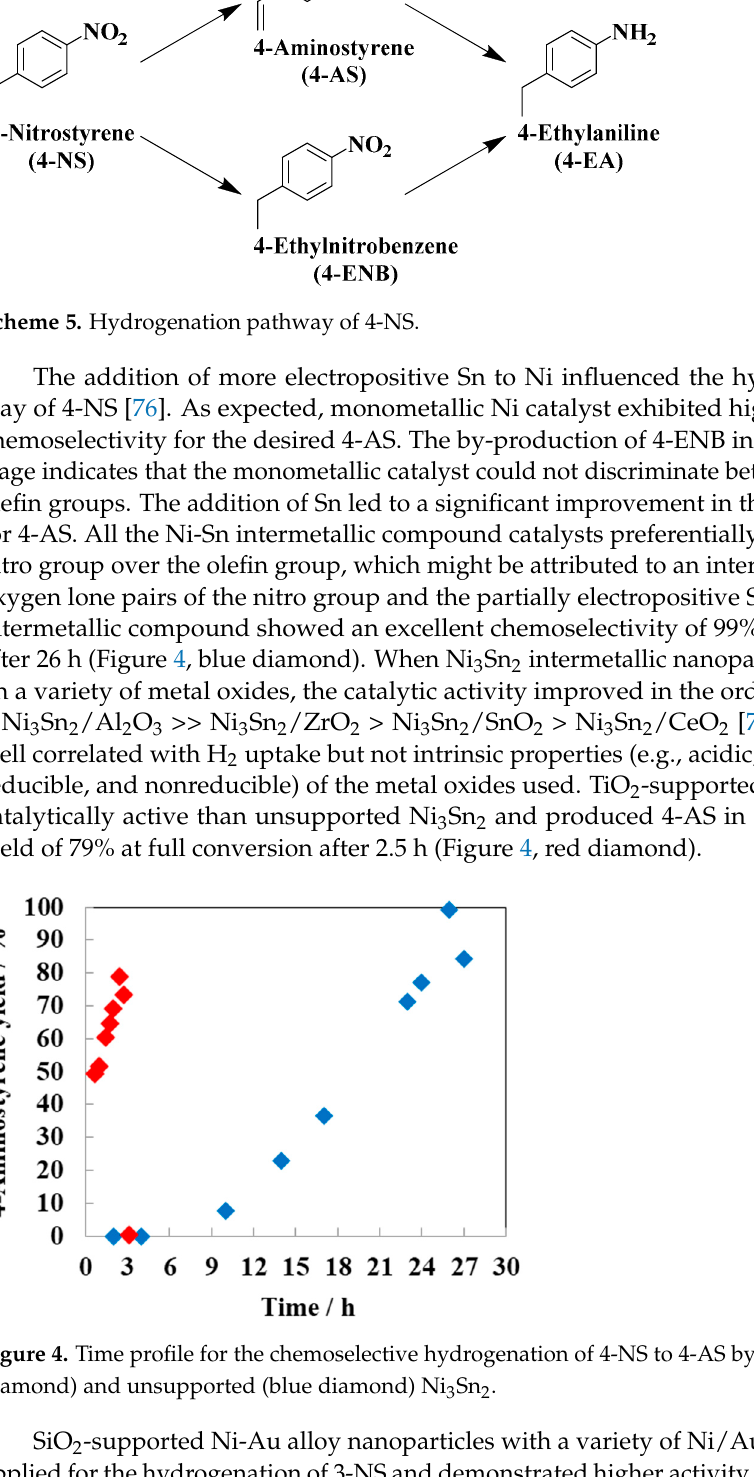
Figure 4. Time profile for the chemoselective hydrogenation of 4-NS to 4-AS by TiO 2 -sup- ported (red diamond) and unsupported (blue diamond) Ni 3 Sn 2 .